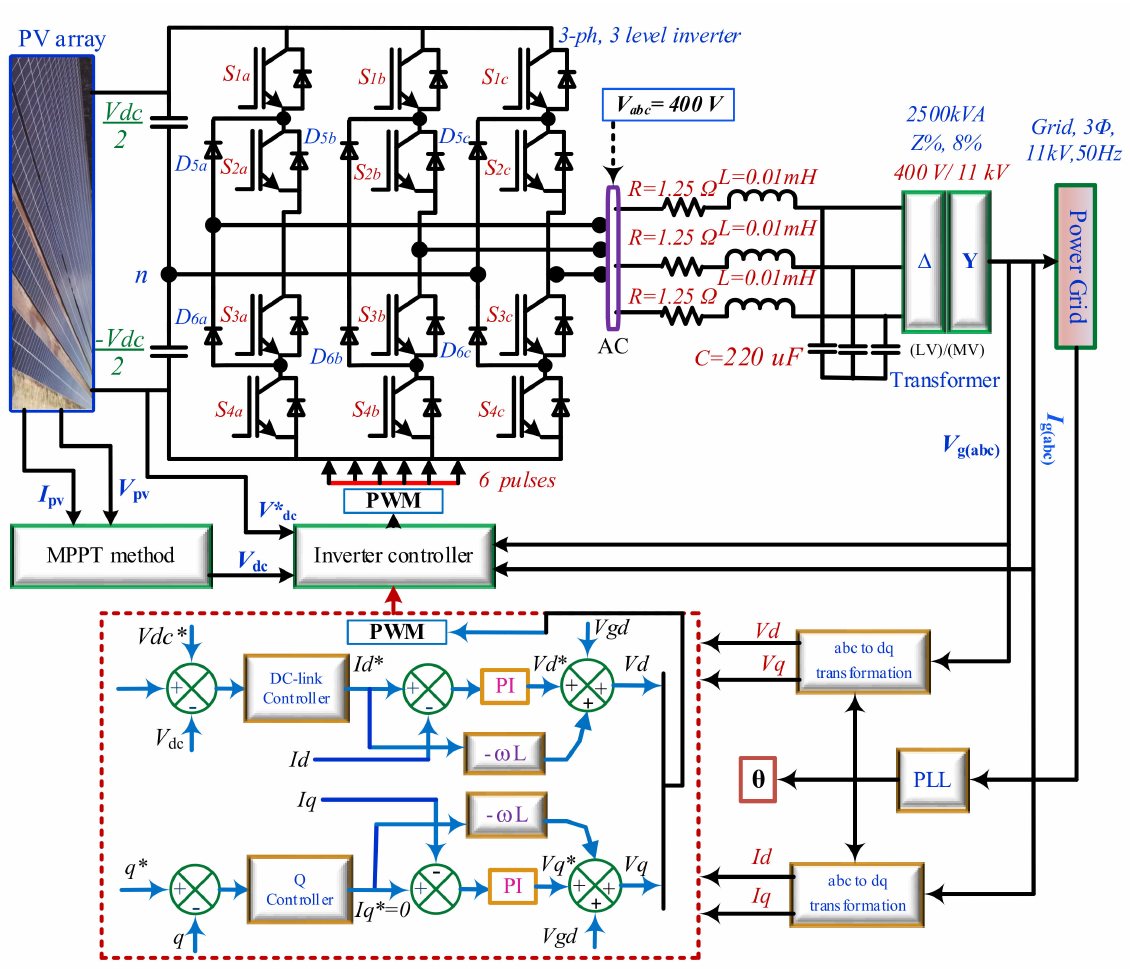
Figure 4. Synchronized rotating frame control of the three-phase three-level inverter: Schematic